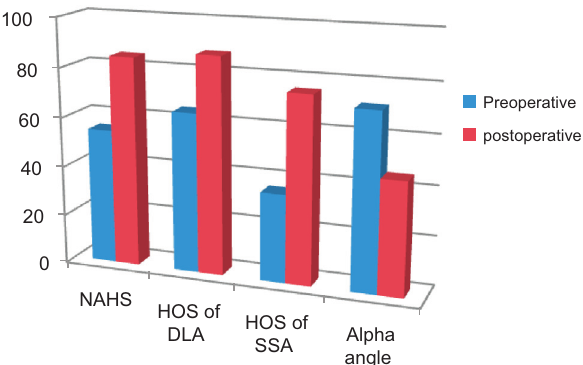
Figure 2. Chart illustrating the change in functional scores and alpha angle from preoperative to